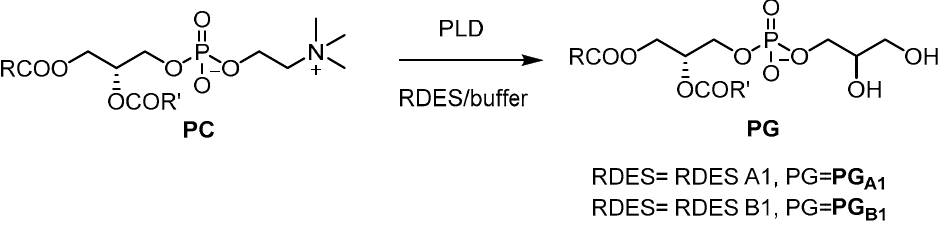
Figure 4. Transphosphatidylation of PC to PG.